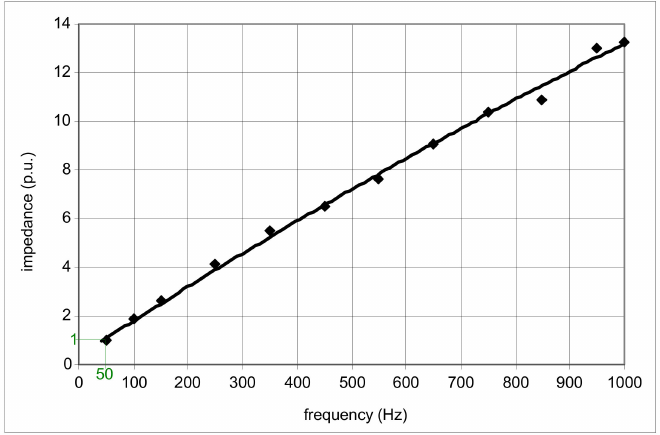
Figure 19. Impedance variation (measured) of the example relay (just before tripping) of the 30 mA A-type RCD, within the frequency range f = 50–1000